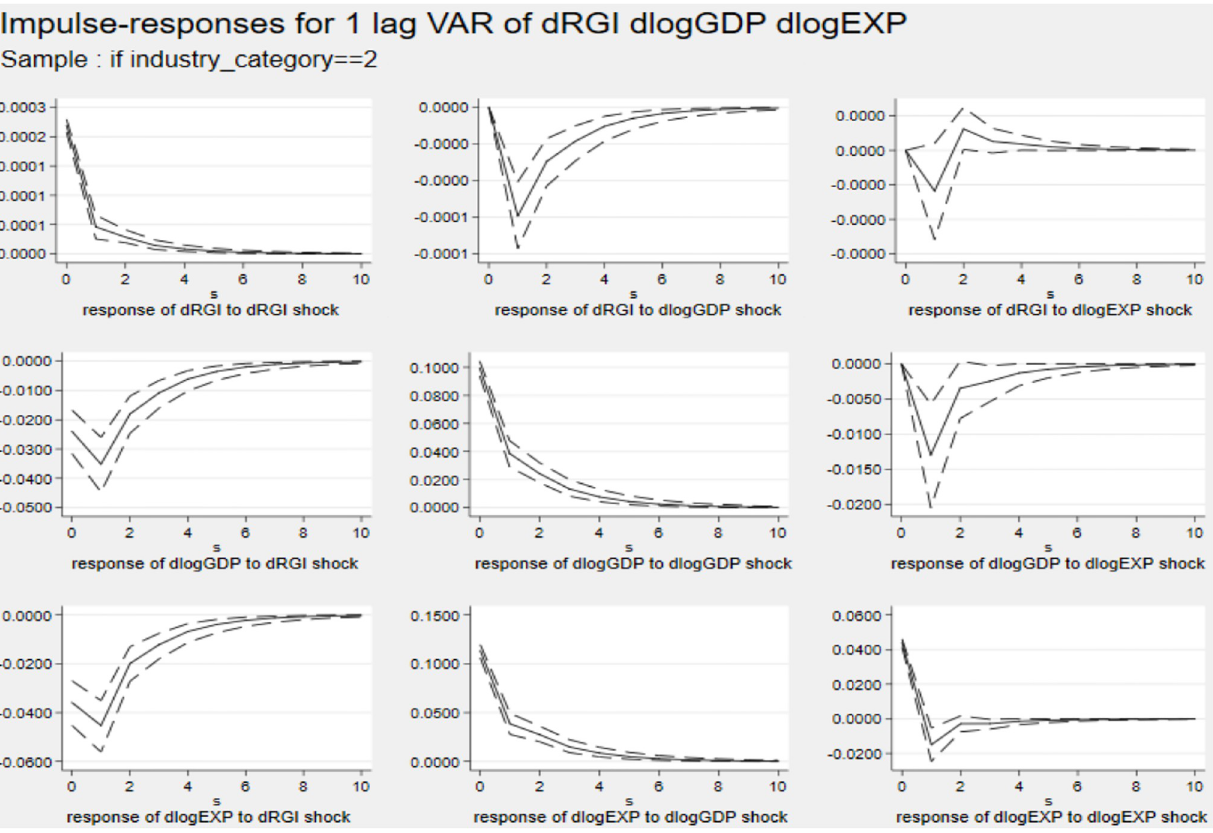
Fig 7. Impulse response diagram in Cluster 6. Notes : Errors are 5% on each side generated by Monte-Carlo with 2000 reps.